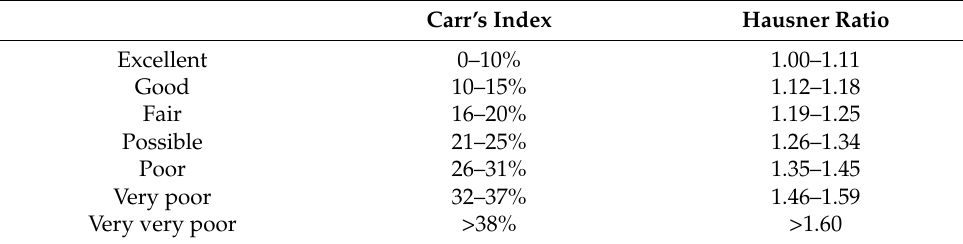
Table 2. Specifications for the Carr’s index and the Hausner